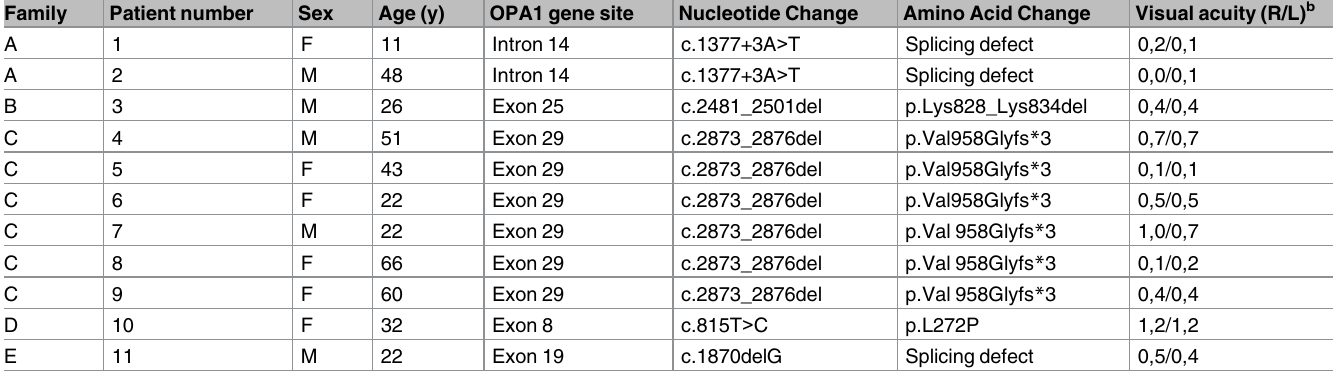
Table 1. OPA1 mutations a , clinical and demographic data in 9 patients with